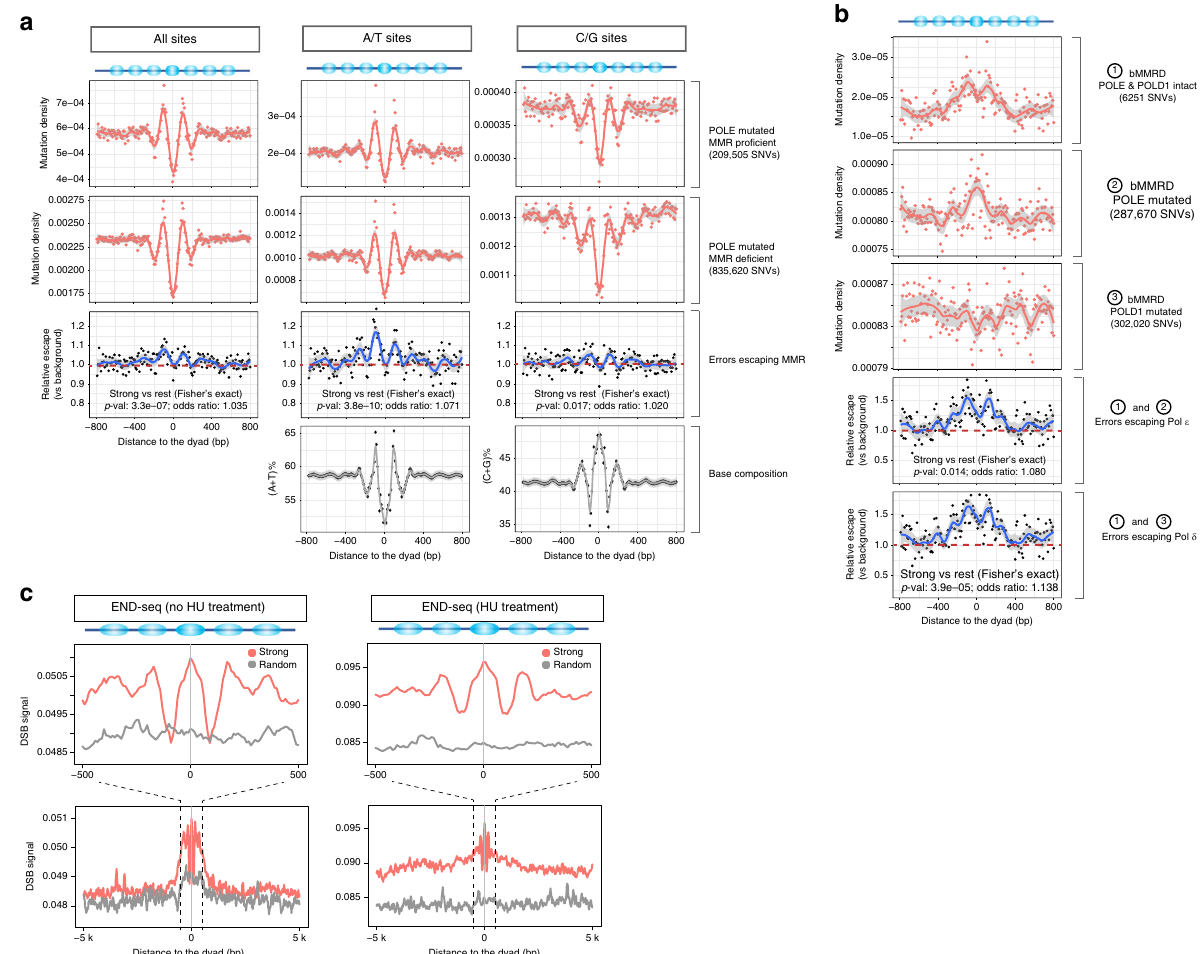
Fig. 4 Mismatch repair (MMR), DNA polymerase fi delity, and double-strand breaks (DSB) explain increased mutation rates in strong nucleosomes. a Mutation density pro fi les relative to strong-nucleosome dyads in cancer genomes harboring driver mutations in the POLE and MMR pathway genes. Numbers of mutations used are indicated in the brackets. The MMR escape ratio compares the mutation densities in the MMR-pro fi cient and MMR- de fi cient genomes. b Mutation density pro fi les relative to strong-nucleosome dyads for bMMRD cancer genomes with different driver mutation statuses in the POLE and POLD1 genes. The escape ratios compare the mutation densities for Pol ε -de fi cient and Pol δ -de fi cient cancers with the pro fi cient ones. c END-seq signal indicating the density of DSBs relative to strong-nucleosome dyads. HU hydroxyurea. Two-sided Fisher ’ s exact test was used for testing the association of strong nucleosomal regions (dyad± 95bp) with differential MMR/polymerase performance. Source data are provided as a Source Data fi